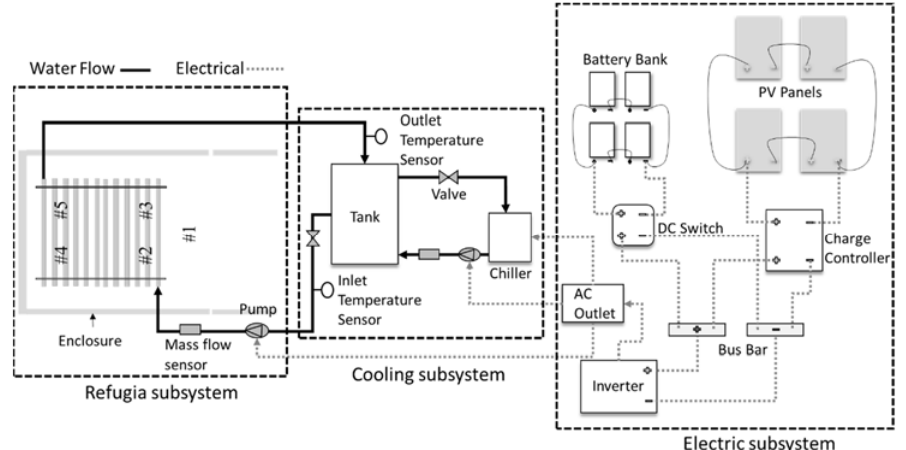
Figure 1. Schematic diagram of the thermal refugia system (not drawn to scale).